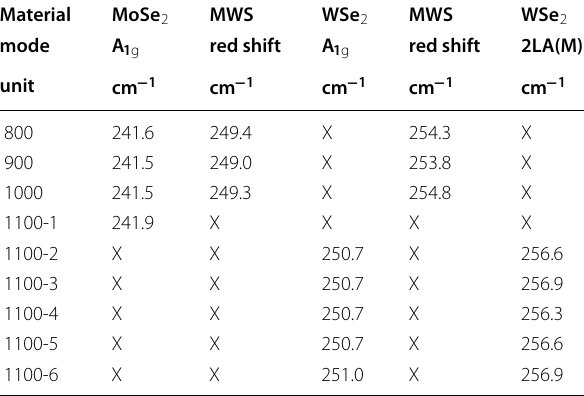
Table 1 List of Raman spectra peak in bulk MoSe 2 and WSe 2